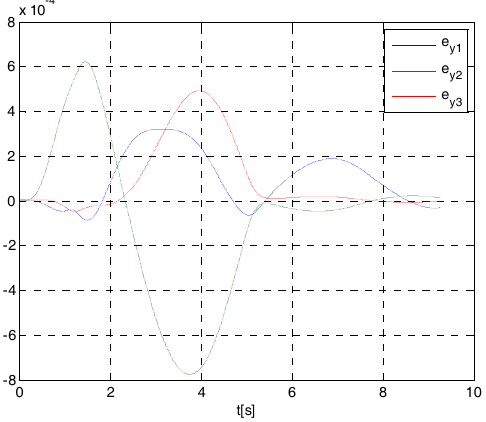
Figure 25. Time histories of , n e